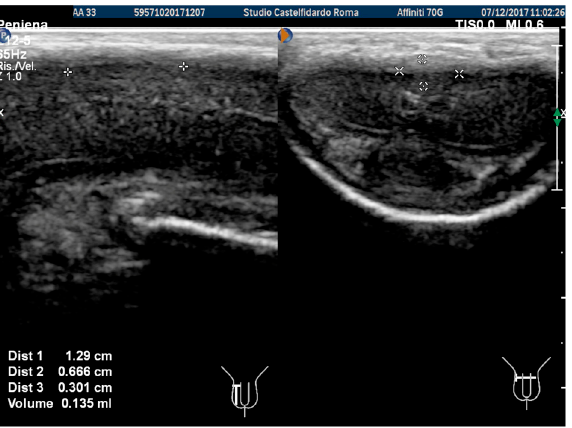
Figure 6. Ultrasonography of the penis after the 1st therapy cycle (longitudinal and axial views). Compared to its initial measurement, the plaque had therefore undergone a 38.3% reduction in volume.